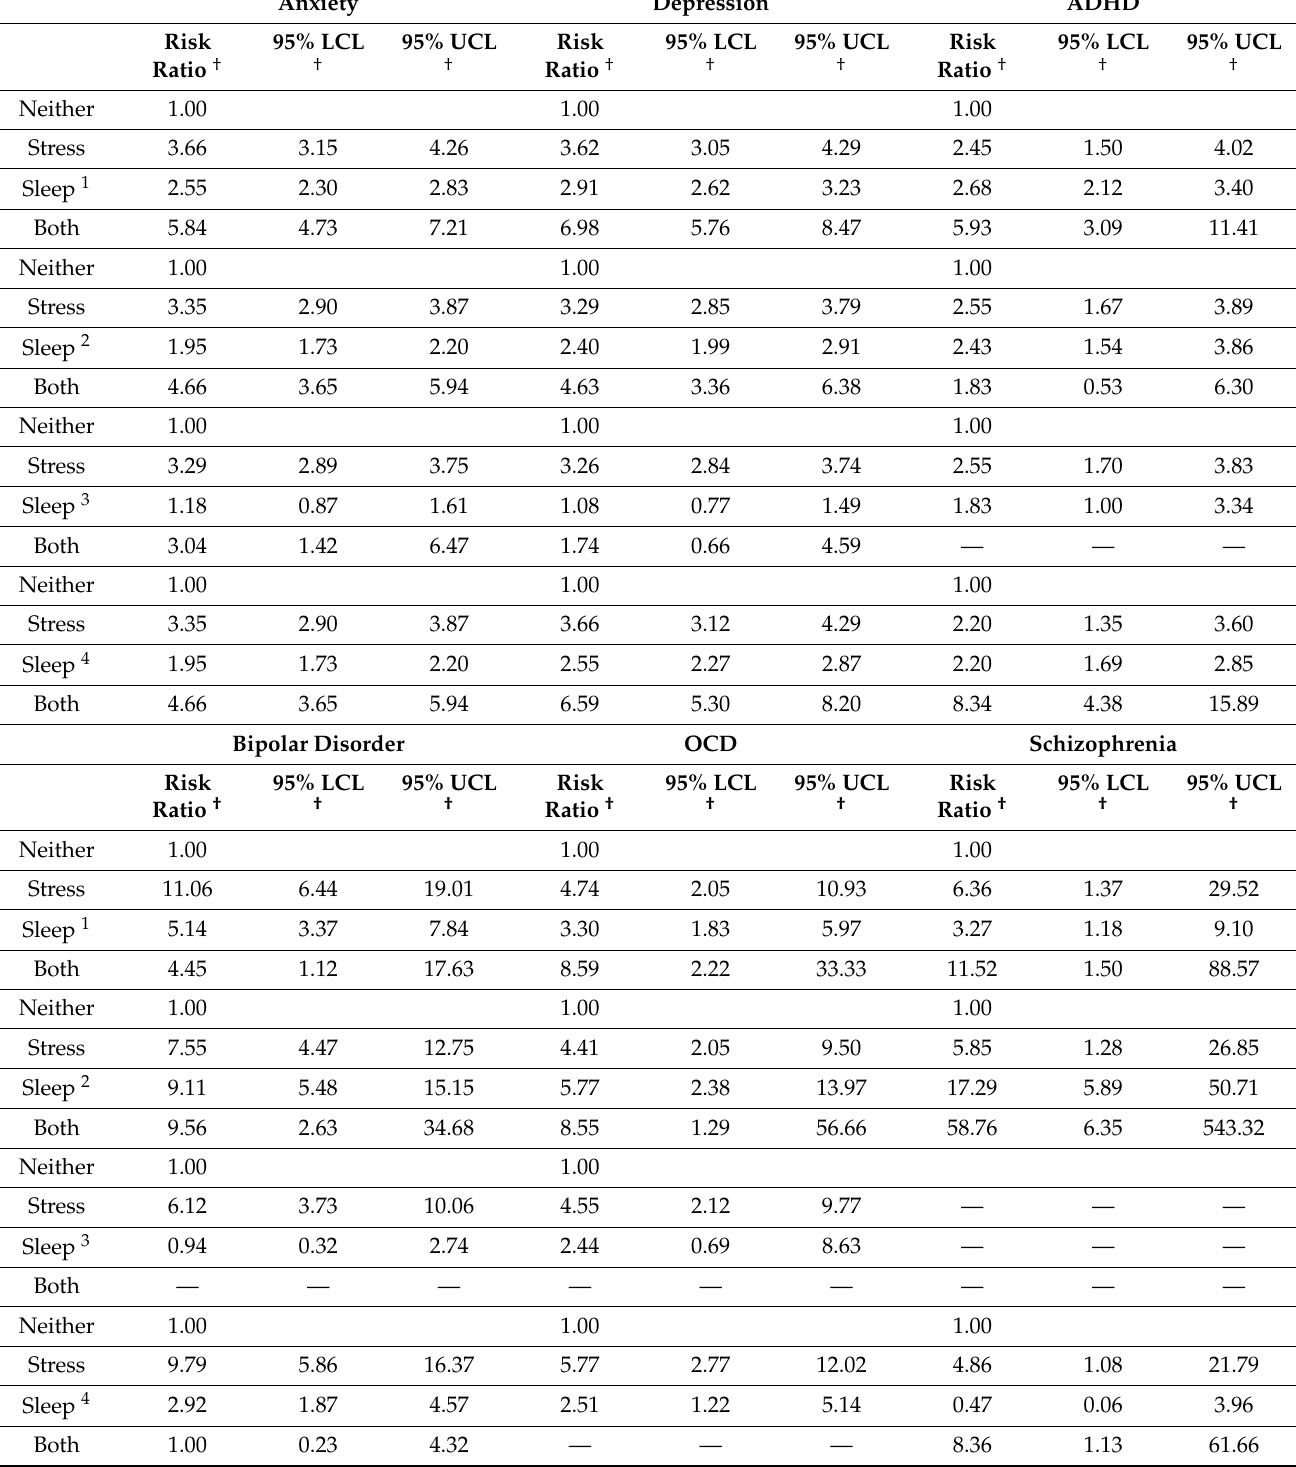
Table 4. Risk of Selected Types of Mental Health Conditions in Contract Holders According to Stress and Sleep Status, 2020. Anxiety Depression